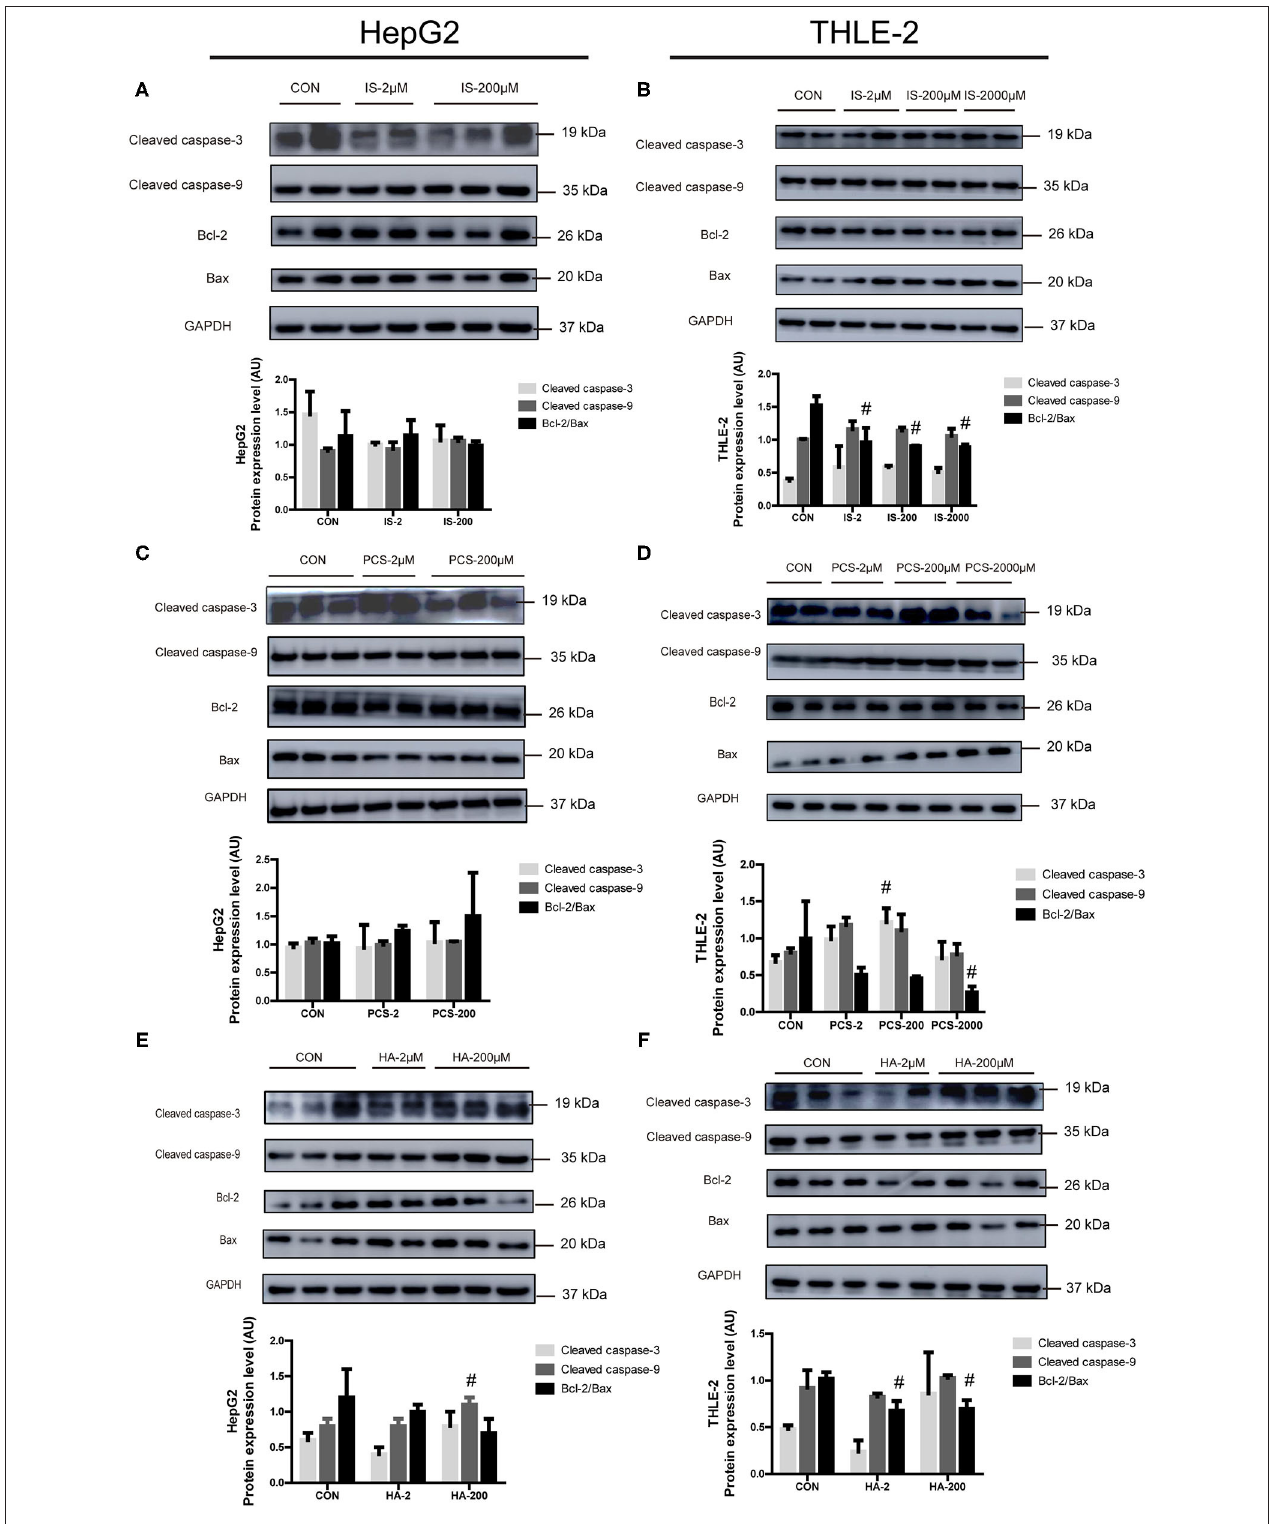
FIGURE 3 | Effects of PBUTs on the apoptotic apoptosis protein expression in hepatocytes. HepG2 and THLE-2 cells were treated as detailed in section “Materials and Methods.” (A,B) Effects of IS on apoptosis protein expression. (C,D) Effects of PCS on apoptosis protein expression. (E,F) Effects of HA on apoptosis protein expression. HepG2 and THLE-2 cells were examined for apoptosis protein using Western blot. Bar graphs display quantification of blots. For all bar graphs, the data are the mean ± SD ( n = 2-3). #, P < 0. 05 vs. CON group. The significant difference was assessed using the one-way ANOVA followed by LSD posttests.